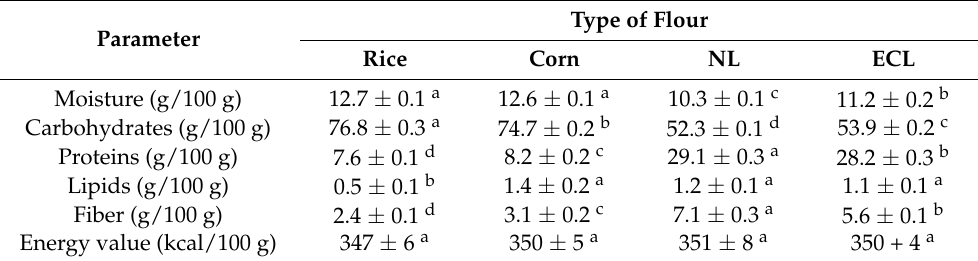
Table 2. Nutritional composition and energy value of the flours used for preparing the